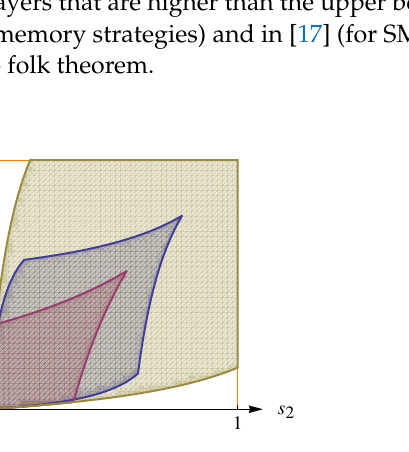
Figure A5. The blue set corresponds to all ESD. The brown set corresponds to distributions with individually rational payoffs (greater or equal to 0); the red set corresponds to distributions such that both payoffs are in range [ 0,5 ]